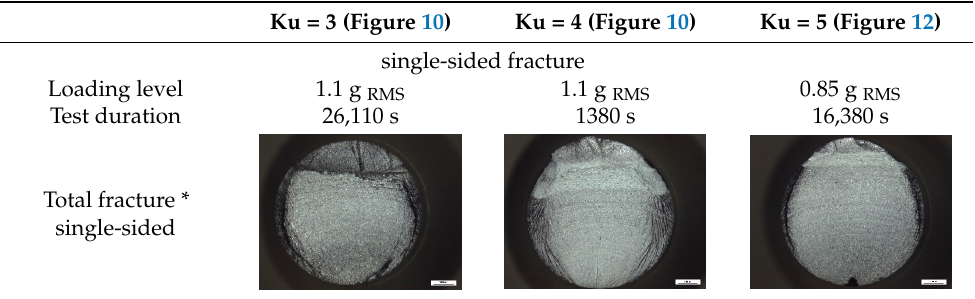
Table 9. Summary of one-sided fatigue fractures obtained under various load conditions.